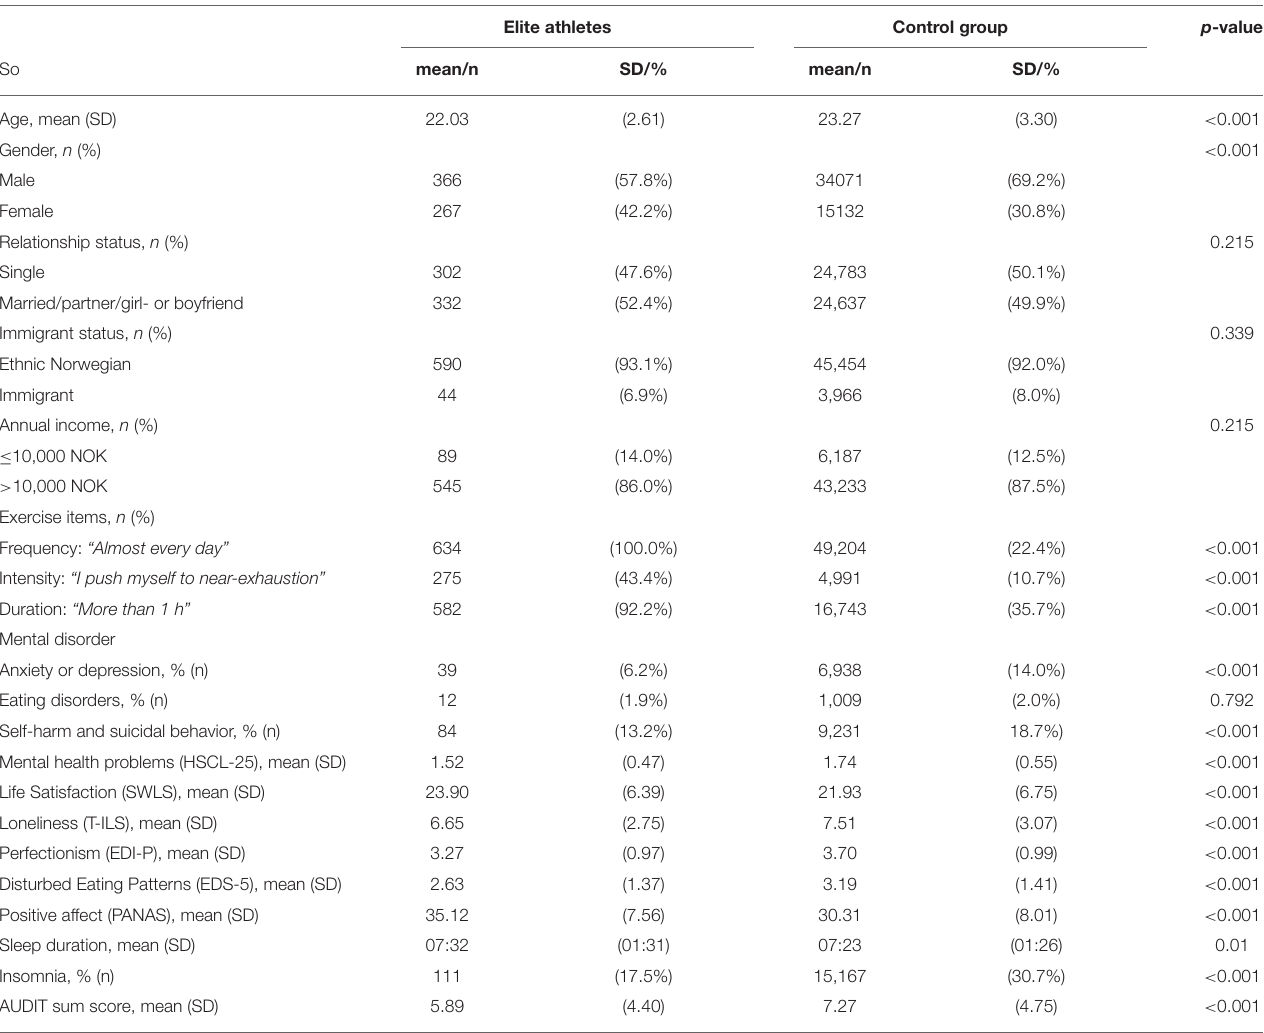
TABLE 1 | Sociodemographic and clinical characteristics of the SHoT 2018 study. Elite athletes Control group p